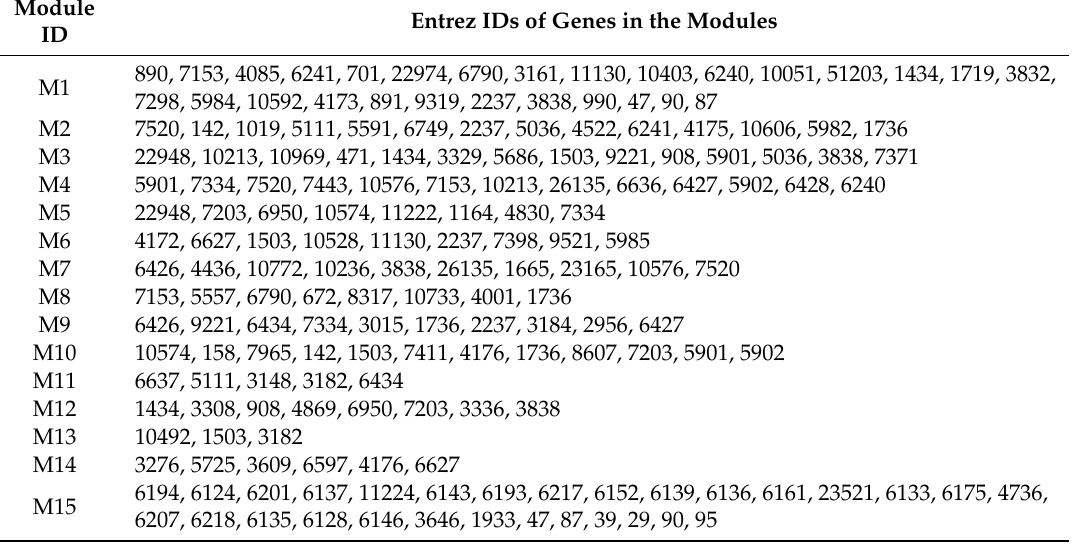
Table 1. Selected candidate drug-target modules based on genes a ff ected by